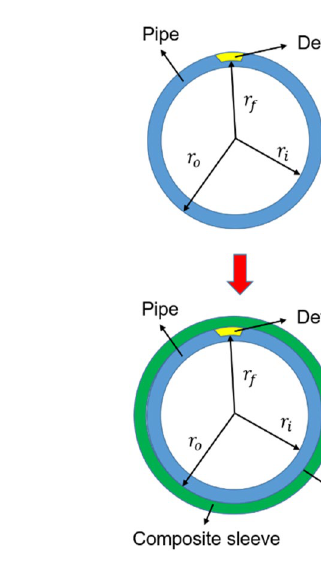
Fig. 2 Composite repair system applied to the corroded